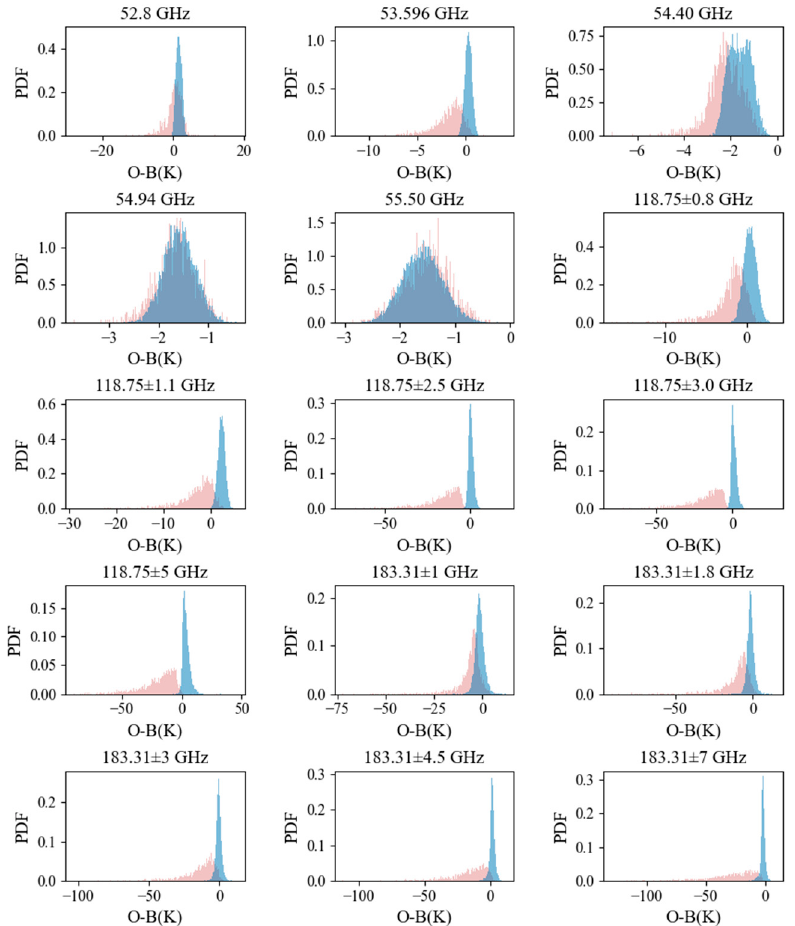
Figure 16. Probability density distribution of O − B values for the screened out clear sky points and the rejected cloudy points over ocean. The blue part of the figure indicates the probability density distribution of the filtered clear sky points, and the pink part indicates the probability density distribution of the rejected cloudy points.